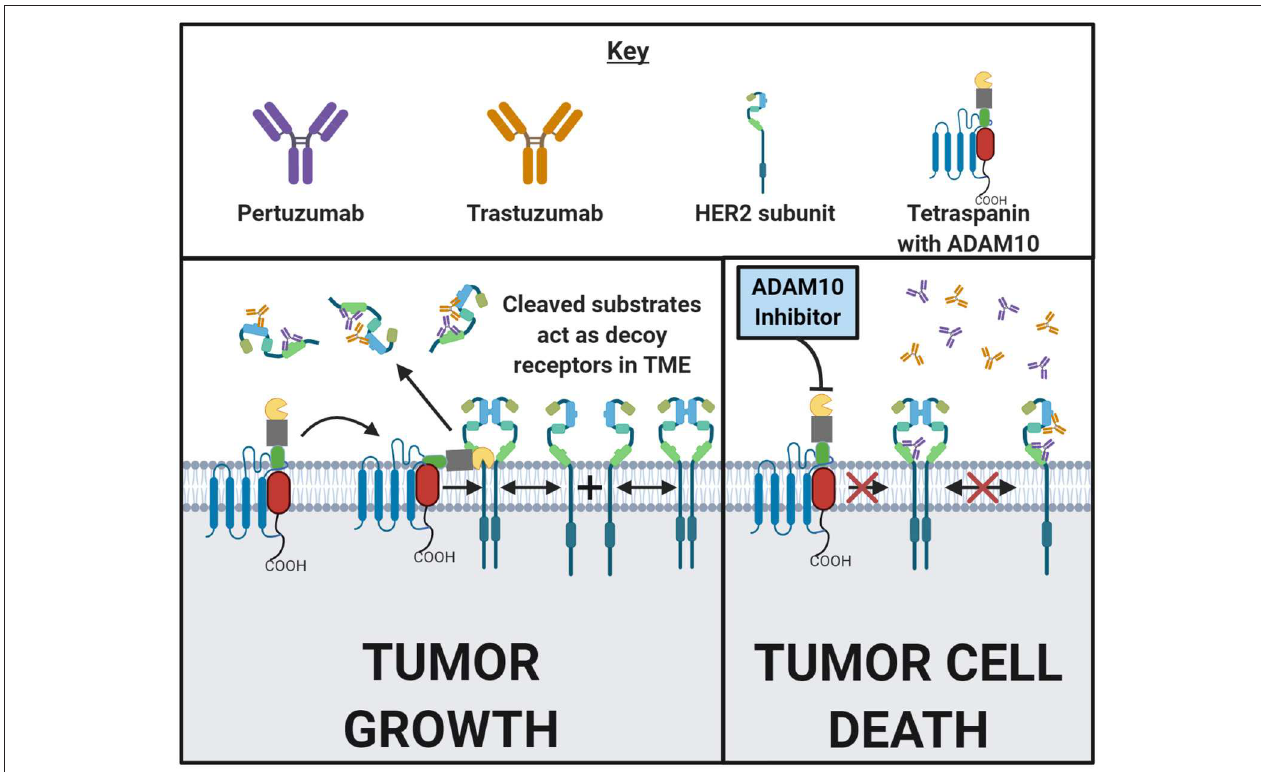
FIGURE 1 | ADAM10 mediates cell surface cleavage of a large repertoire of substrates that can promote a pro-growth environment in malignant tumors. Some of these ADAM10 substrates, such as HER2, are targeted by FDA approved drugs. Following HER2 subunit dimerization with HER- family subunits, and upon ligand-binding or autoactivation, a pro-growth signal cascade is initiated which then drives malignancy. Trastuzumab and pertuzumab are both monoclonal antibodies that bind to two distinct epitopes of HER2 to prevent homodimerizaton and heterodimerization, respectively. In addition to inhibiting dimerization, tumor cells with bound antibody have an increased likelihood of succumbing to antibody dependent cellular cytotoxicity (ADCC) or opsonization. In the left and right panels above, a HER2-positive cancer cell surface in the presence of trastuzumab and pertuzumab is depicted. In the left panel, ADAM10 cleaves the extracellular domain of HER2 from the cell surface into the tumor microenvironment (TME). These cleaved domains then act as decoy receptors, decreasing the amount of trastuzumab or pertuzumab that binds to the tumor cell. The likelihood of ADCC or opsonization is now decreased. In the right panel, treatment with trastuzumab or pertuzumab is combined with the inhibition of ADAM10. Inhibiting ADAM10 results in less HER2 cleavage which reduces the amount of decoy receptors in the TME. Decreasing the decoy receptors in the TME and increasing the amount of HER2 on the tumor cell might enhance trastuzumab’s and/or pertuzumab’s antitumor effects. This general concept can be applied to other ADAM10 substrates in other disease states. Made in © BioRender - biorender.com.